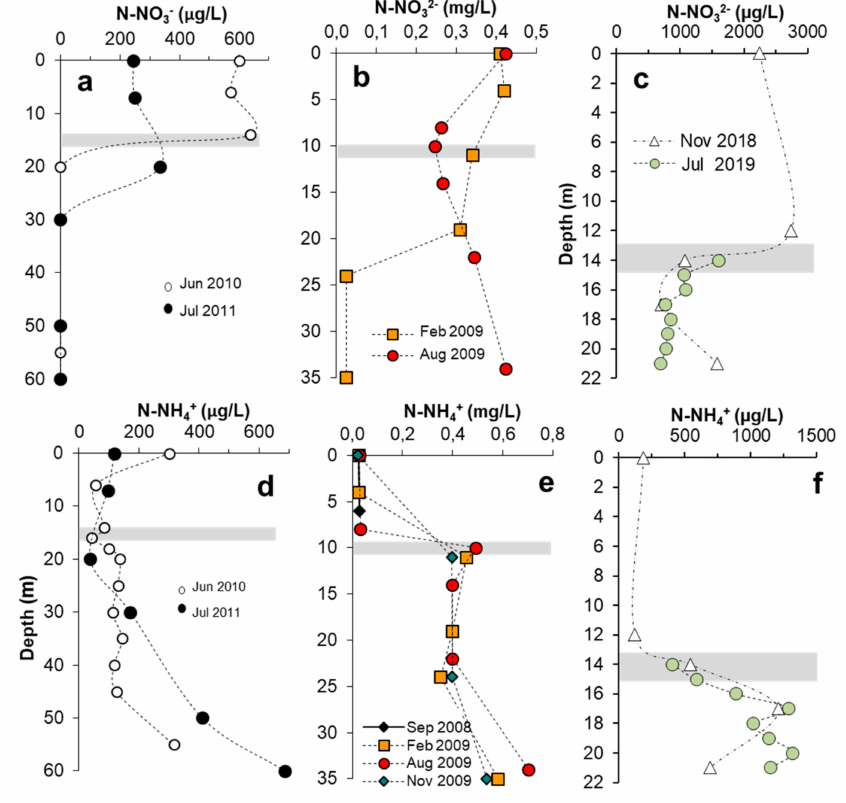
Figure 9. Vertical variation of nitrate-nitrogen (N-NO 3 − , a – c ) and ammonium-nitrogen (N-NH 4 + , d – f ) concentration in Herrer í as ( a , d ), Cueva de la Mora ( b , e ) and Brunita ( c , f ) acidic pit lakes, as measured in di ff erent seasons. The shaded area indicates the approximate position of the chemocline in all